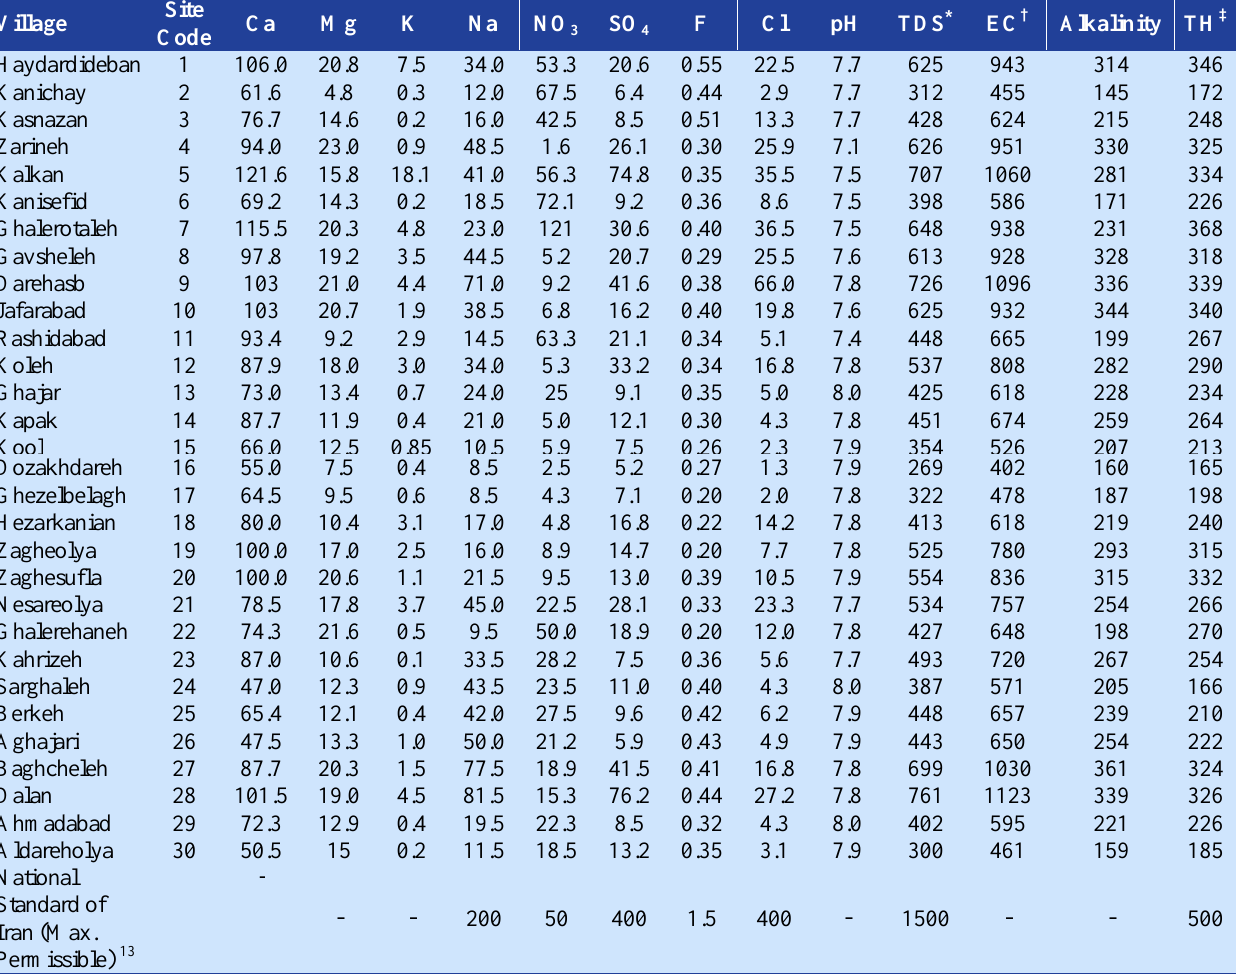
Figure 1. Fluoride concentration of different sampling sites in low- and high-water seasons Table 1. Average values of physicochemical parameters of groundwater in rural